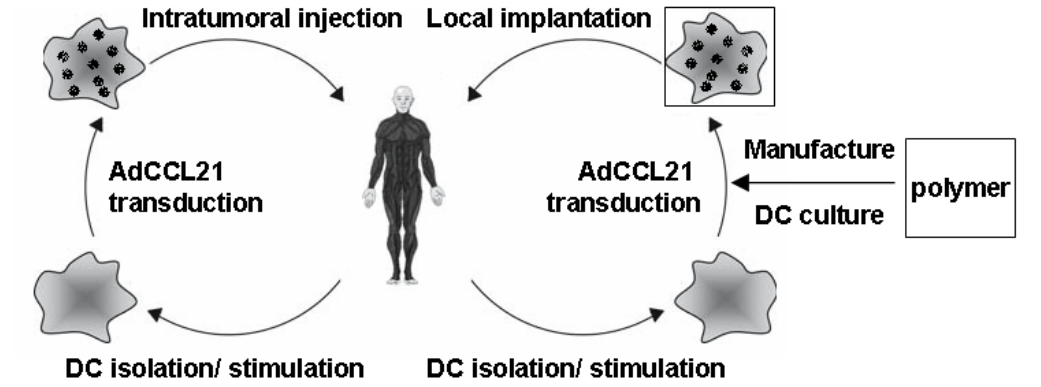
Figure 1. DC-CCL21 Immunotherapy ( Left ) Patient-DCs are isolated from PBMC and stimulated with 800 U/mL GM-CSF and 400 U/mL IL-4 for 6 days. Transduction with clinical grade adenoviral vector encoding CCL21 generates CCL21 secreting DCs (DC-CCL21), which are injected into patient’s tumor; ( Right ) DC-CCL21 cultured in fibrin hydrogel in PCL-PLCL polymer platform overnight for potential implantation in the tumor following surgical resection (proposed clinical trial for